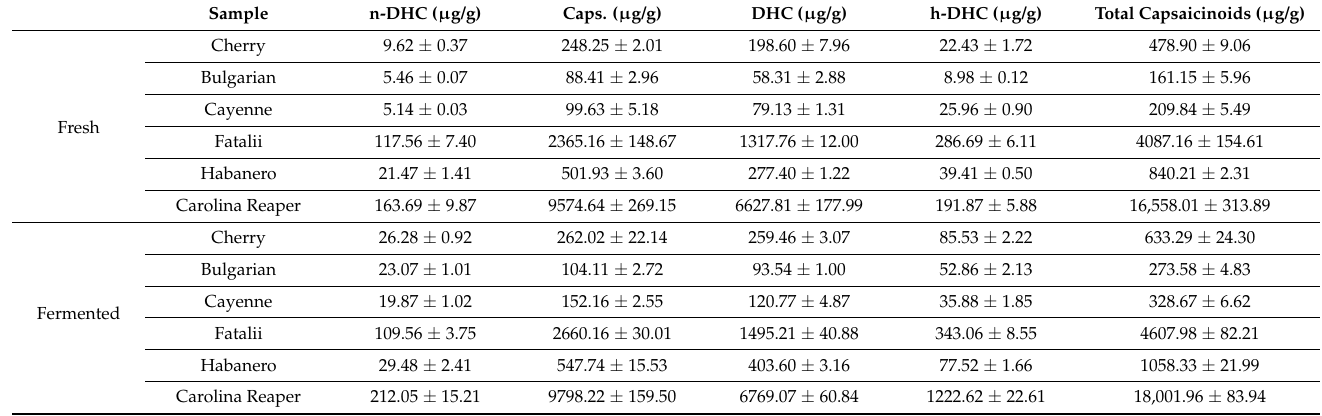
Table 3. Distribution of different capsaicinoids in tested samples ( µ